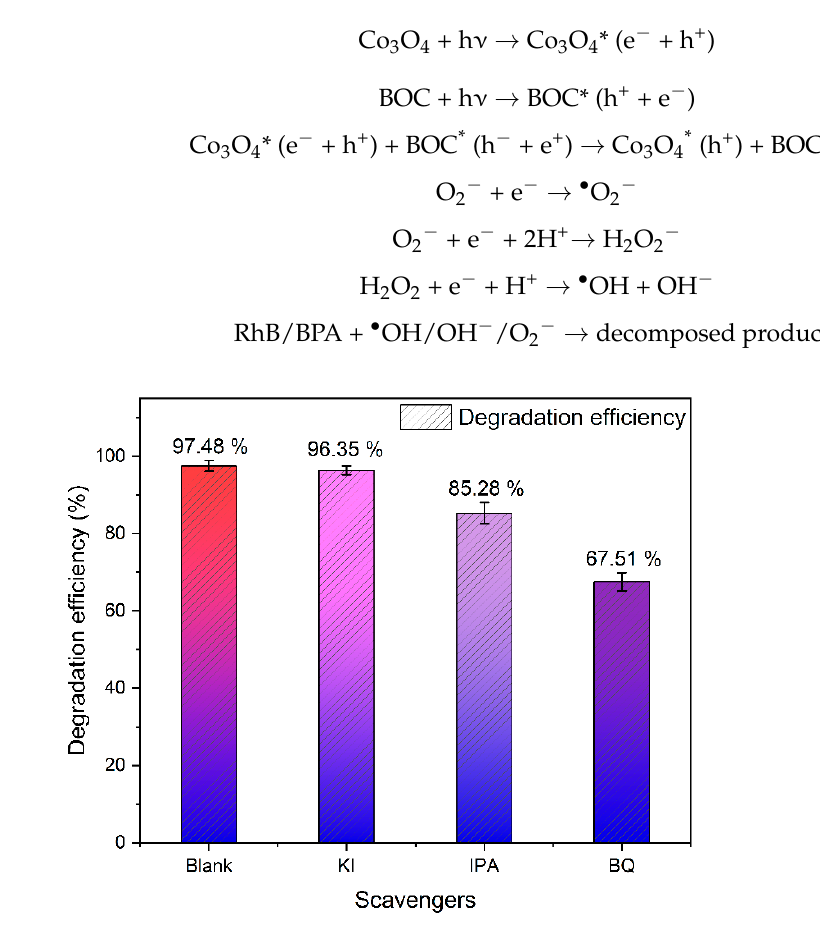
Figure 7. Active radicals detection in the presence of various scavengers during RhB degradation.